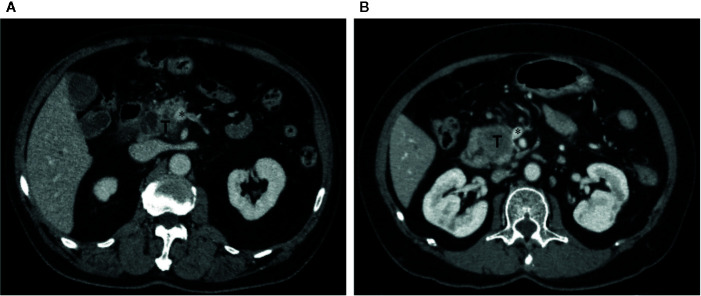
Representative cases which were reclassified after Radscore assistance. (A) Axial portal venous phase CT image in a 73-year-old man with PDAC in the pancreatic head. The vein was suspiciously deformed (*). The Radscore prediction gave a high probability of PV-SMV invasion. The interpretation of deformity of the vein between unassisted and Radscore-assisted was discrepant for both radiologists, they assigned PV-SMV invasion category with Radscore assistance. Intraoperative exploration confirmed the diagnosis of PV-SMV invasion. (B) Axial portal venous phase CT image in a 66-year-old female with PDAC in the pancreatic head. The vein was interpreted as teardrop shape by the junior radiologist (*) in first the reading. The Radscore prediction gave a low probability of PV-SMV invasion. The vein was interpreted as absence of teardrop shape by the junior radiologist (*) in the second reading with Radscore assistance, and PV-SMV non-invasion category was assigned. Intraoperative exploration confirmed the diagnosis of PV-SMV non-invasion.